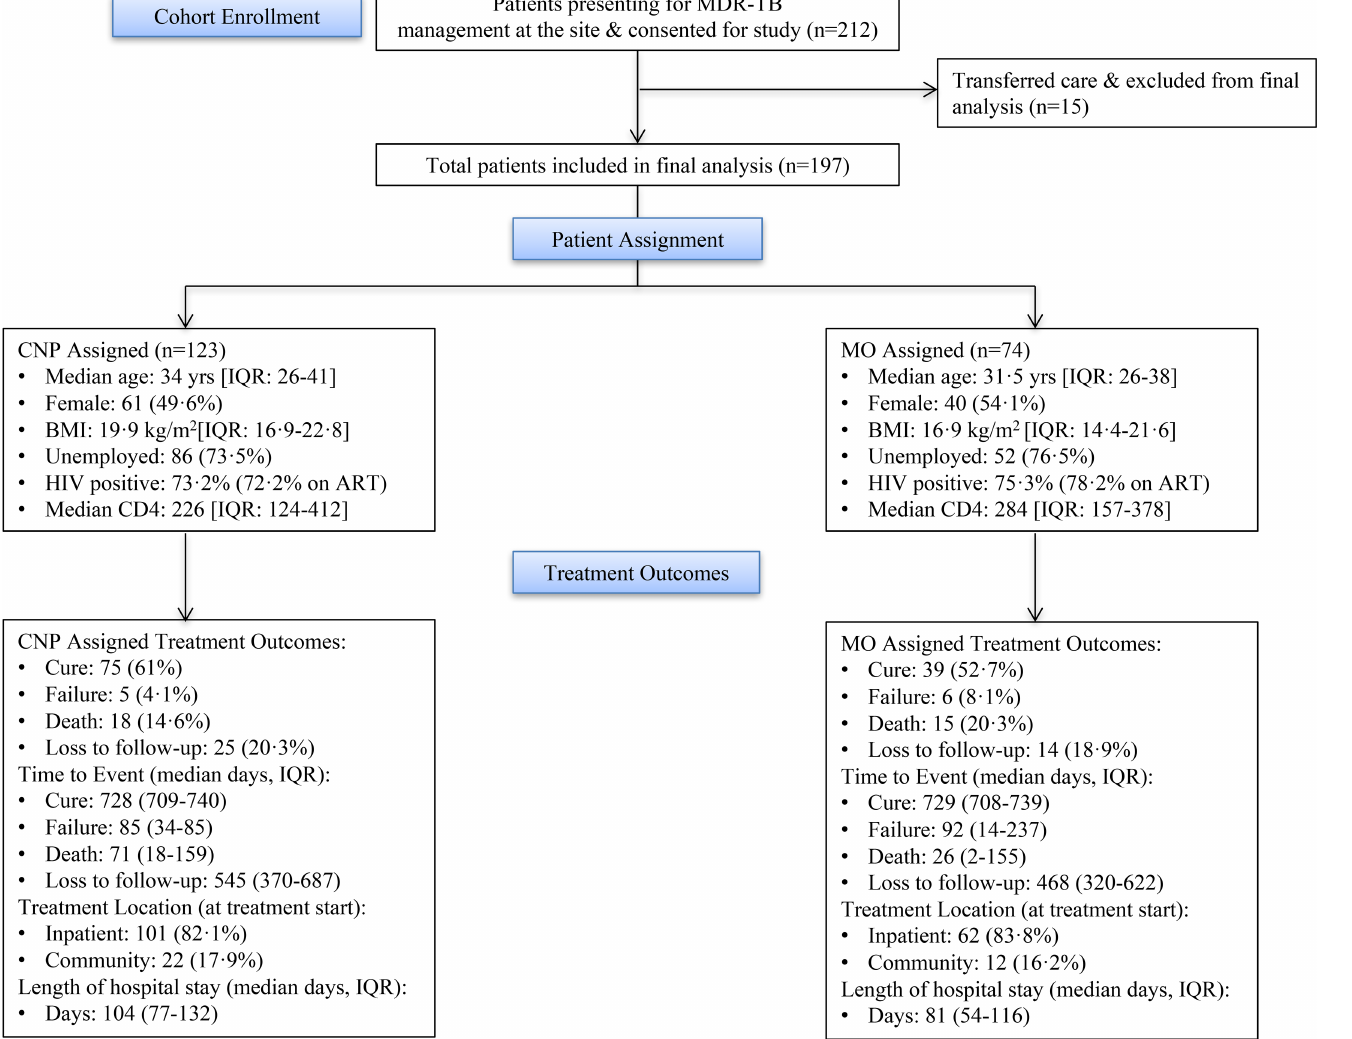
PLOS ONE | https://doi.org/10.1371/journal.pone.0182780 August 4,